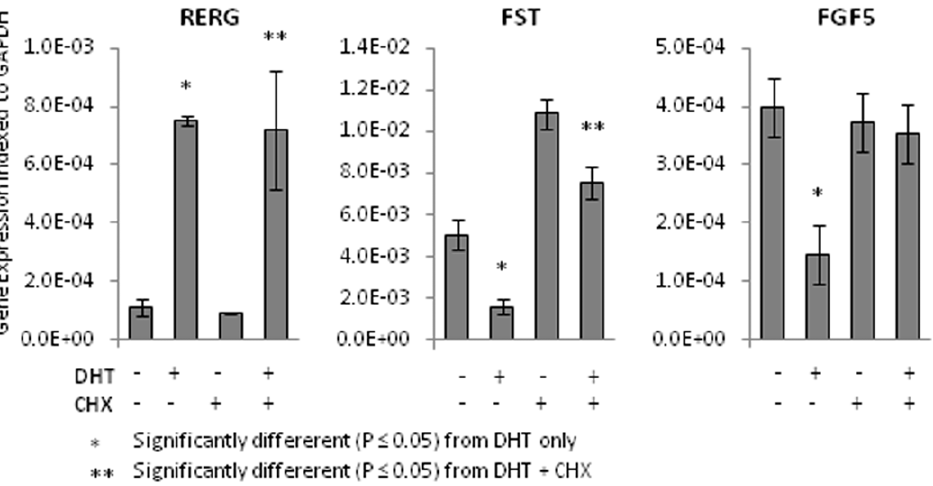
Figure 4. Effects of cycloheximide on gene expression changes in WPMY-AR cells induced by DHT treatment. WPMY-AR cells were pre- treated then treated with cycloheximide in the absence or presence of 10 nM DHT for 24 hrs. RNAs were analyzed by qPCR for the expression of RERG, FST or FGF5, as indicated and expression levels were normalized to GAPDH expression levels.